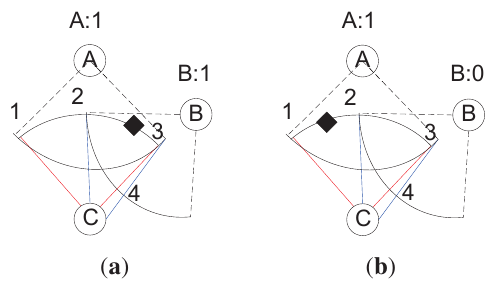
Figure 7. Determination of a target’s